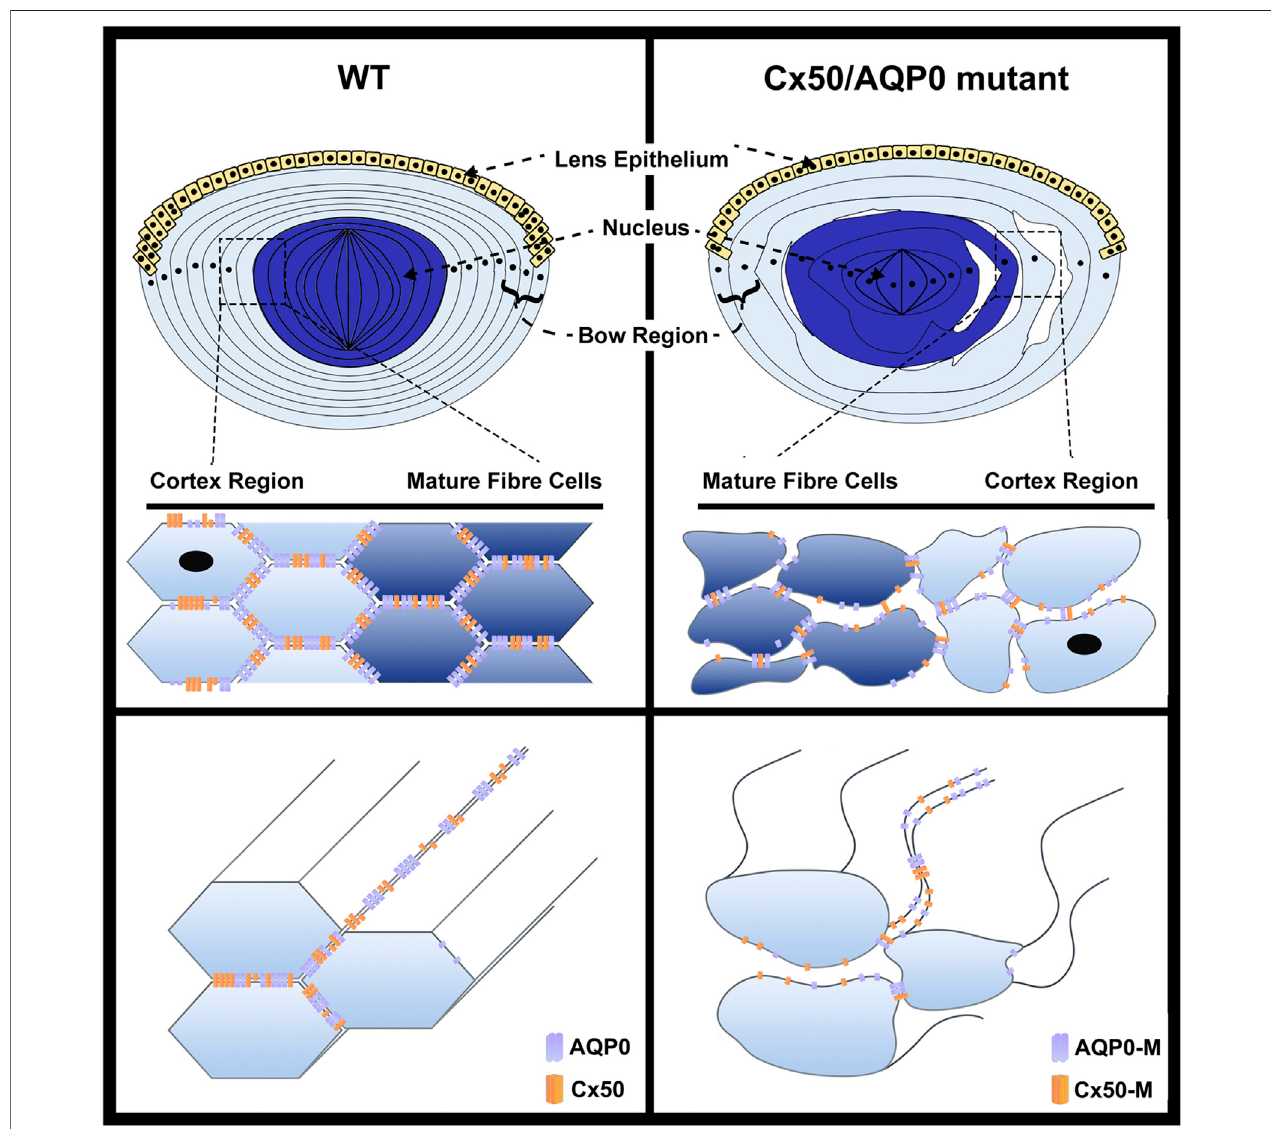
FIGURE 2 | Impairment of cell adhesive function mediated by AQP0 or Cx50 mutation disrupts the organization of lens fi bers. In lens fi bers, AQP0 and Cx50, primarily located at the short side and broad side of mature lens fi bers, respectively, directly interact with each other, and function like “ glue ” to mediate the cell – cell adhesion, which maintains lens fi ber integrity and organization (left upper and lower panels). The hexagon shape indicates cross-section of lens fi ber cells. The lenses showingmutations ofCx50 orAQP0losecell – celladhesion in fi bercells, resultingintheimpairmentofepithelialcellproliferation,increasedintercellular spacesand disorganization of lens fi bers, which consequently leads to loss of lens elasticity and transparency (right upper and lower panels). The complete loss of Cx50 or AQP0 (Cx50 KO or AQP0 KO) lead to a similar levels of fi ber cell disruption.